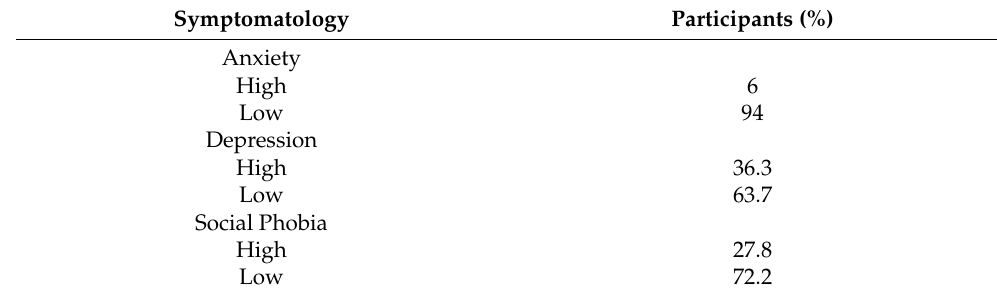
Table 3. Descriptive statistics and information related to the pandemic for the total